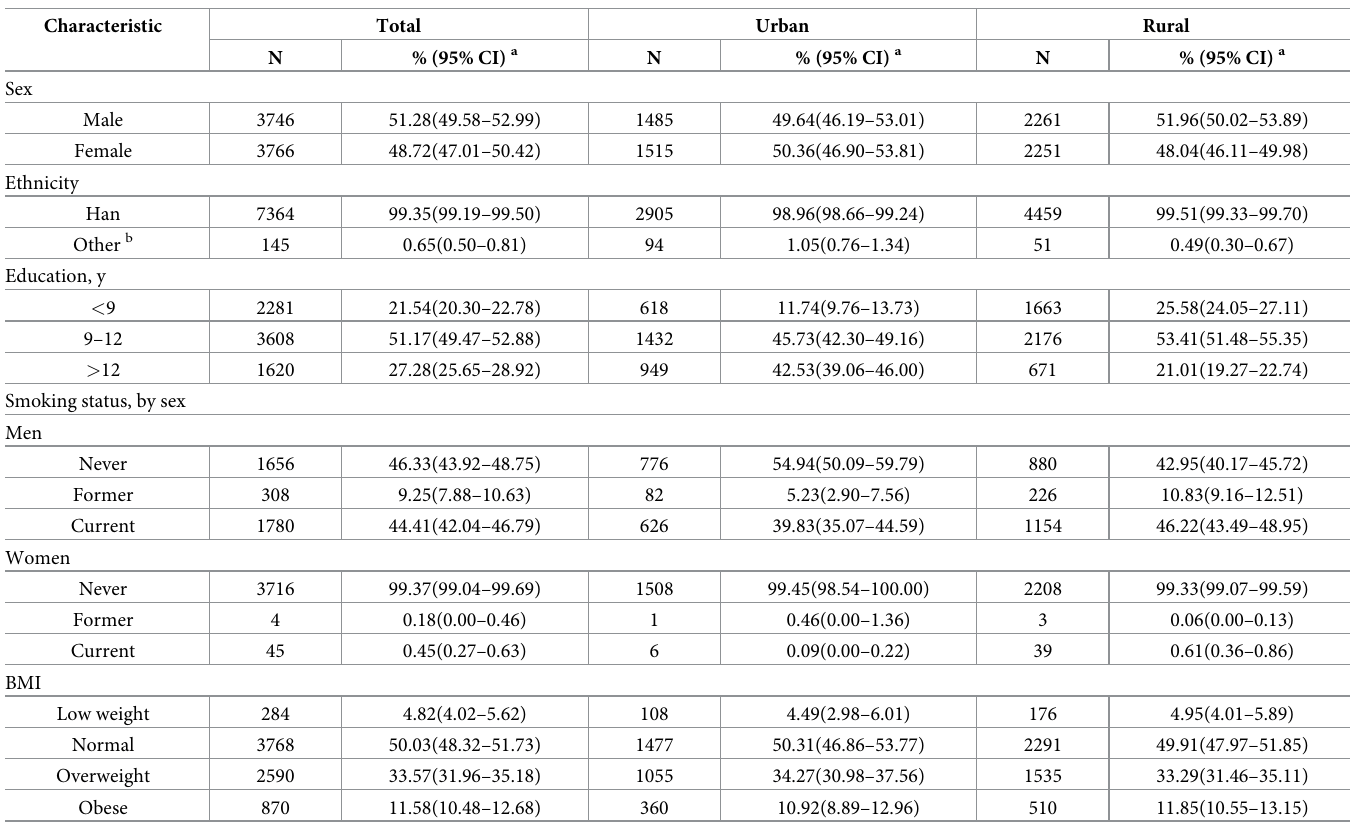
Table 1. Characteristics of study participants (N = 7512) in Zhejiang Province of China in 2017.